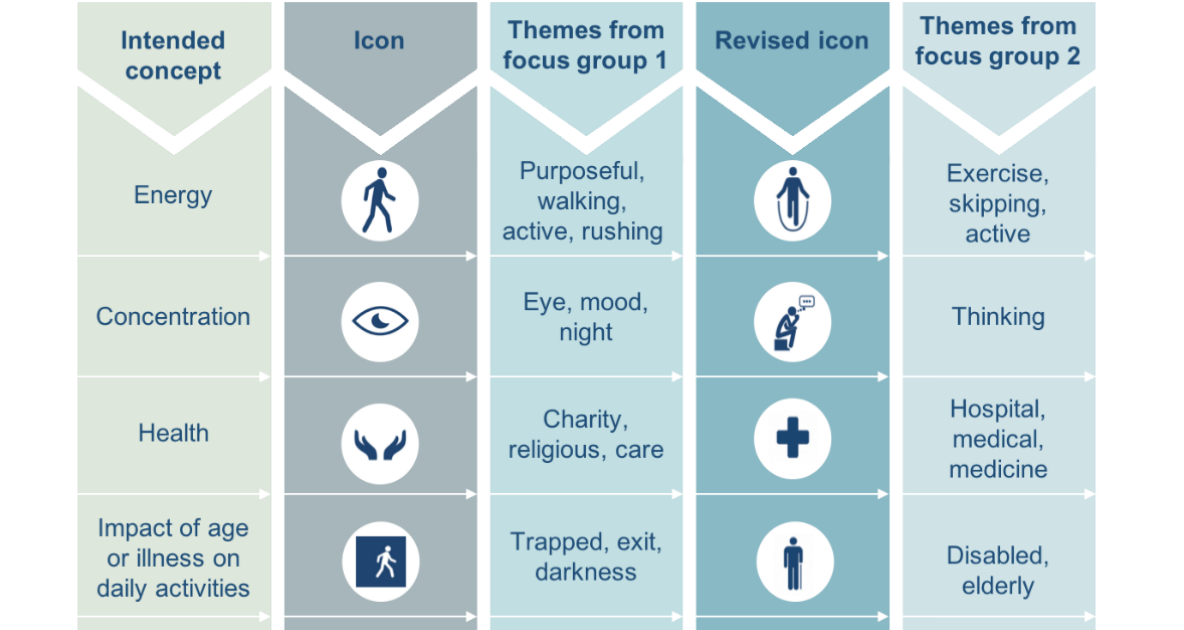
Figure 2. Example of icons replaced and more easily interpreted in prototype